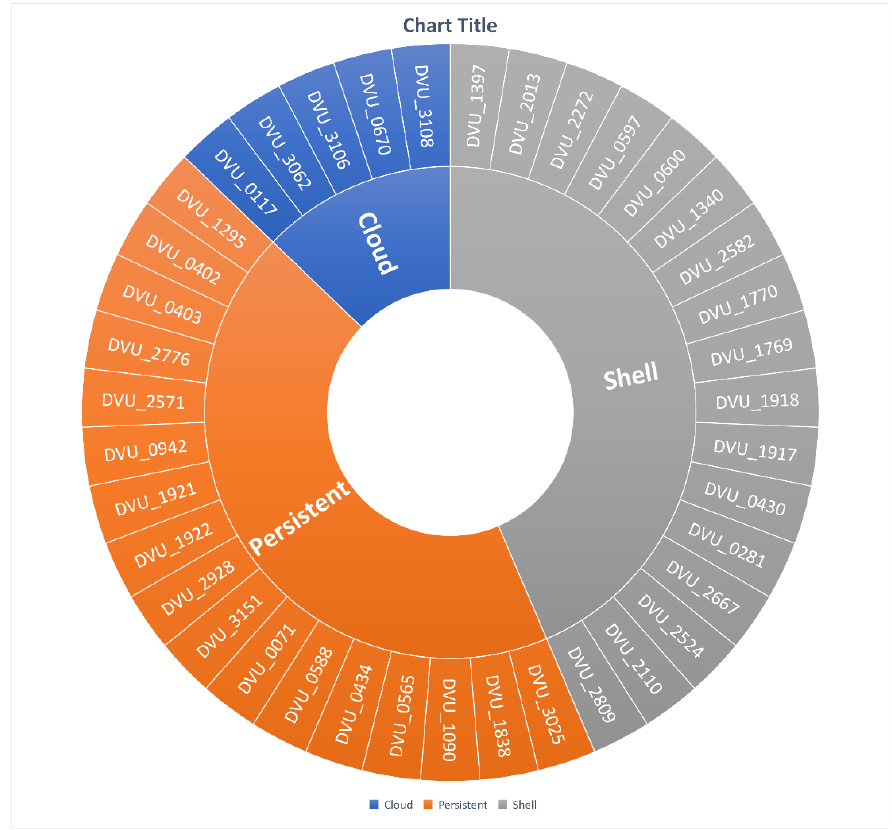
Figure 4. The figure represents the distribution of 39 genes obtained by text mining across 63 SRB pangenomes. Note: see Supplementary Materials Table S4 for more information on these genes.